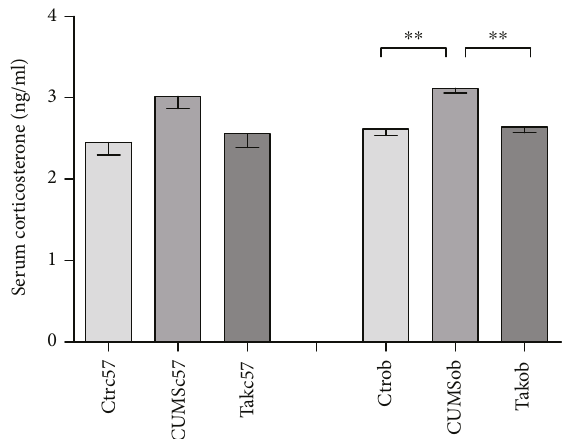
Figure 3: The comparison of serum corticosterone levels in di ff erent groups. Data are expressed as means ± SEM ( n = 6 in each group). ∗∗ p < 0 01